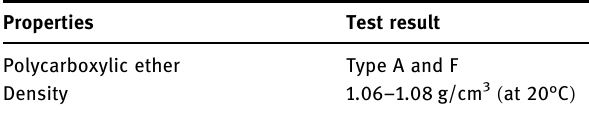
Table 3: Superplasticizer ( Glenium51 ) properties Properties